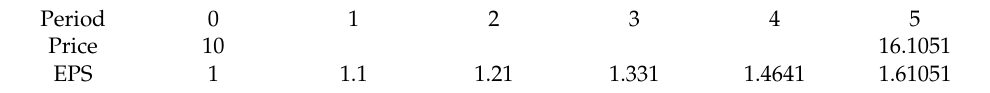
Table 1. Price and Earnings Growth at the Same 10% Rate Over Five Years.